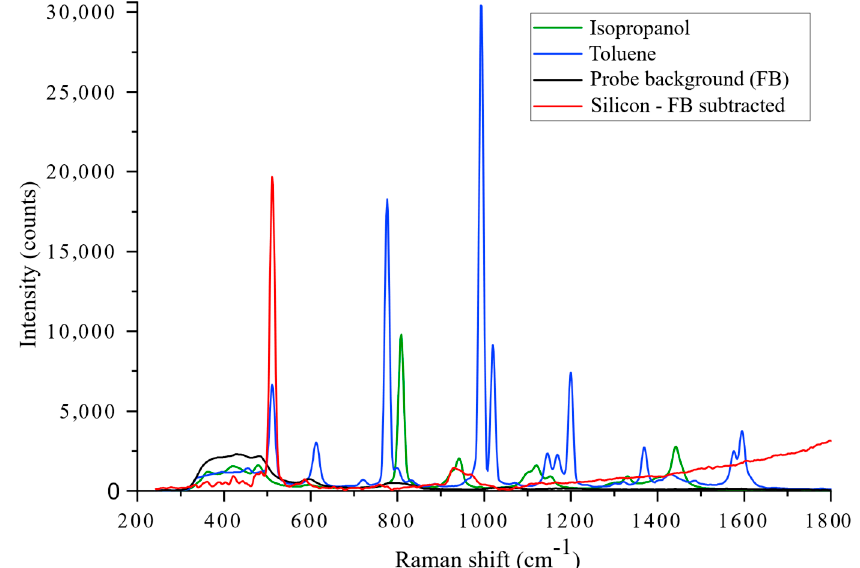
Figure 8. The Raman spectra of common Raman active reference materials obtained with the Raman probe. The spectra shown were measured over 5 s with 25 mW of laser power delivered onto the samples. The spectra are shown without any data processing applied with the exception of the silicon sample (red) which has had the fibre background (FB) (black) removed for clarity.